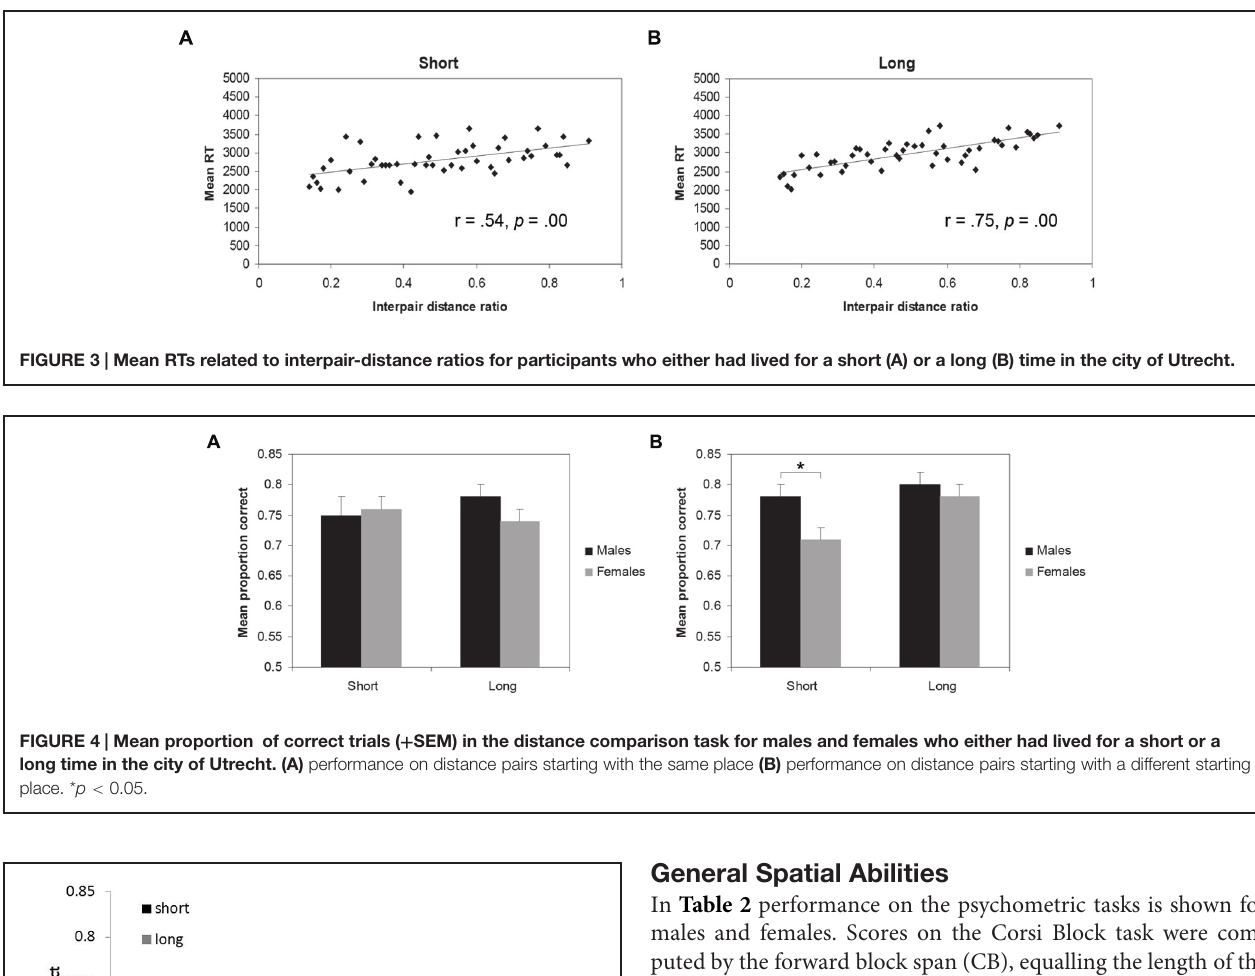
RTs more than 3 SDs above or below the mean were excluded from analyses. RTs did not show any effects. An ANOVA carried and gender and experience (short/long) as between-subjects vari- ables revealed a significant main effect of gender, F (1,77) = 5.4, = 0.07, showing that mean performance was higher p < 0.05; η 2 p in males than in females (see Figure 5 ). Experience was not sig- nificant, F (1,77) = 0.05, p = 0.83, nor was the interaction gender by experience, F (1,77) = 0.63, p = 0.43.